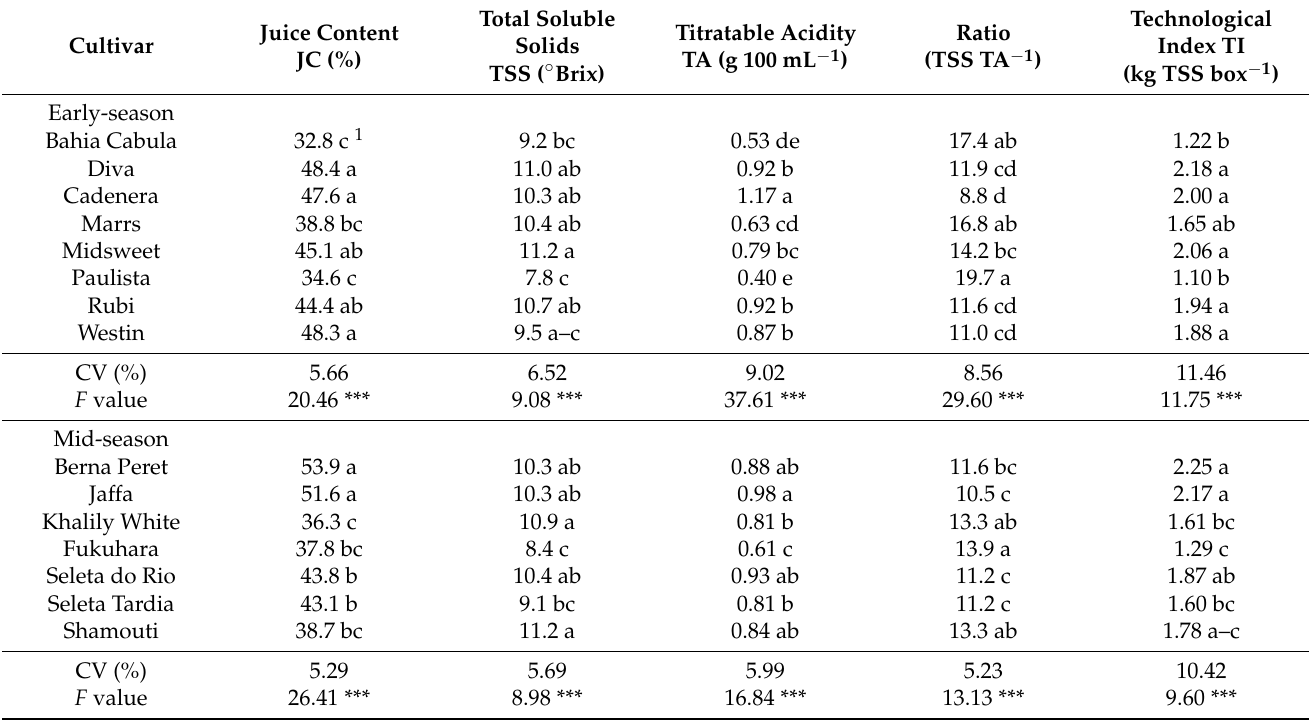
Table 5. Fruit quality of 15 early-season and mid-season sweet orange cultivars produced in Guairaç á , Paran á , Brazil, in the 2019 cropping